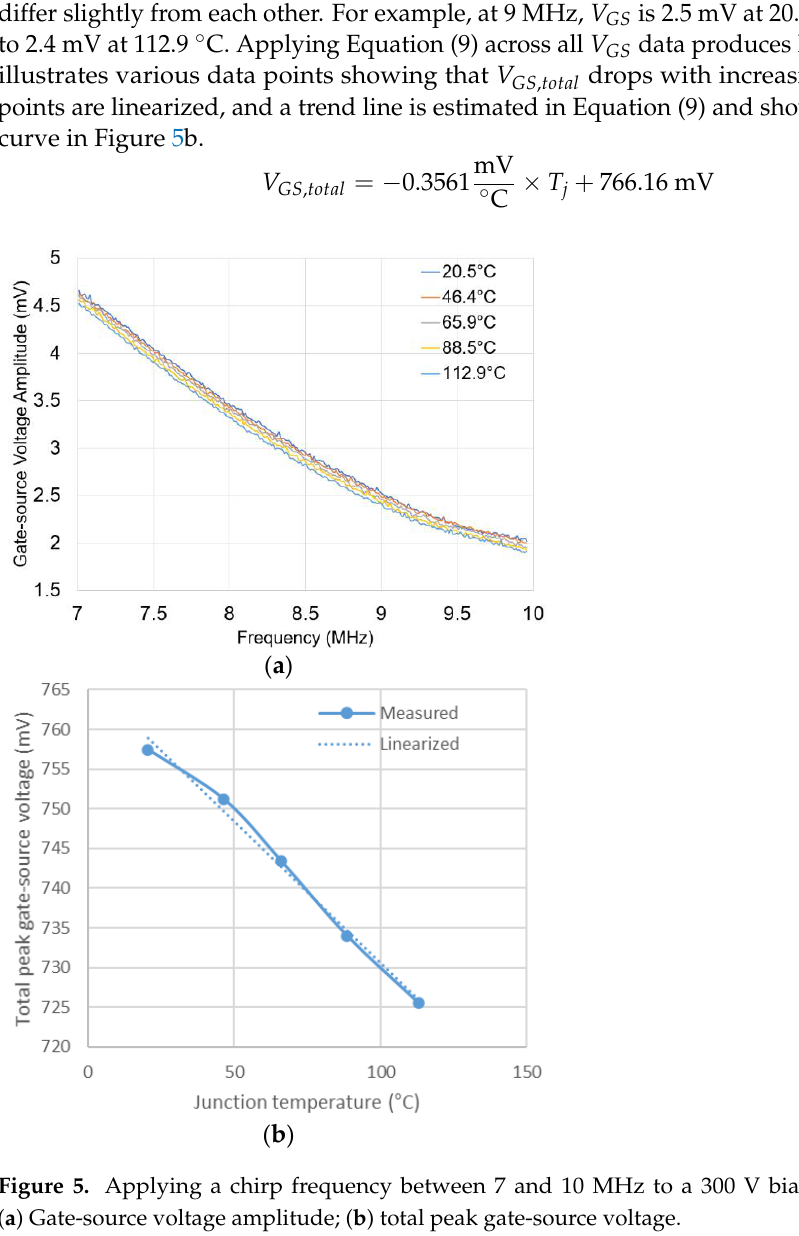
Figure 4. Schematic of the test circuit.